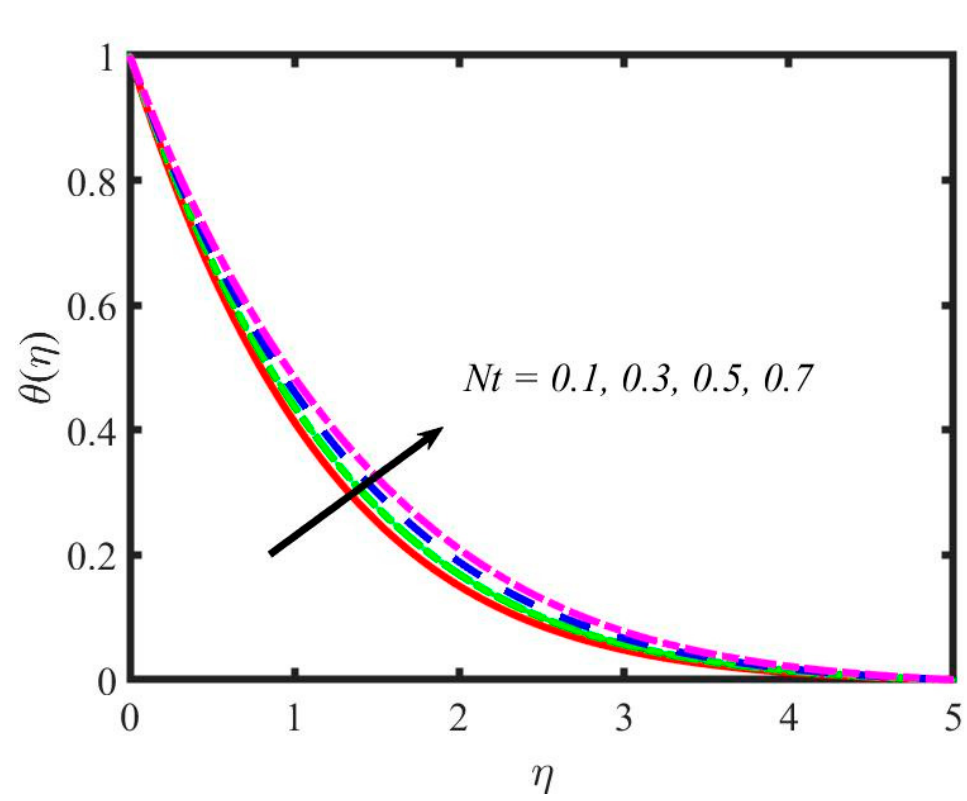
Figure 11. Variations in nanoparticle temperature for Brownian motion parameter.